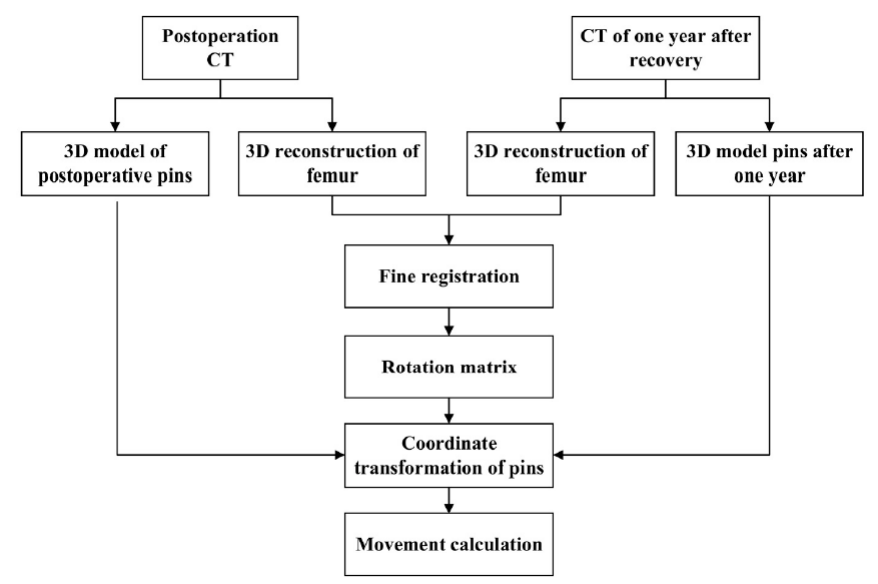
Figure 5. The process of 3D matching of the femur and the pins’ coordinate transformation.